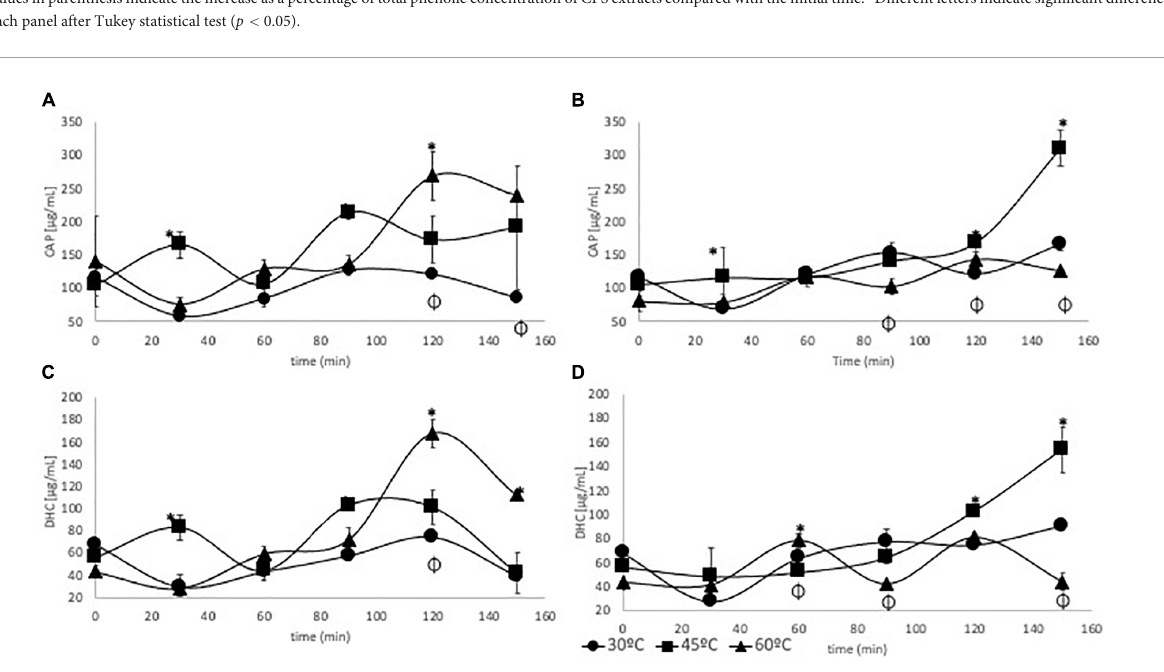
acid, gallic acid, and vanillin shut down the cellulose activity and therefore affected the extraction yield